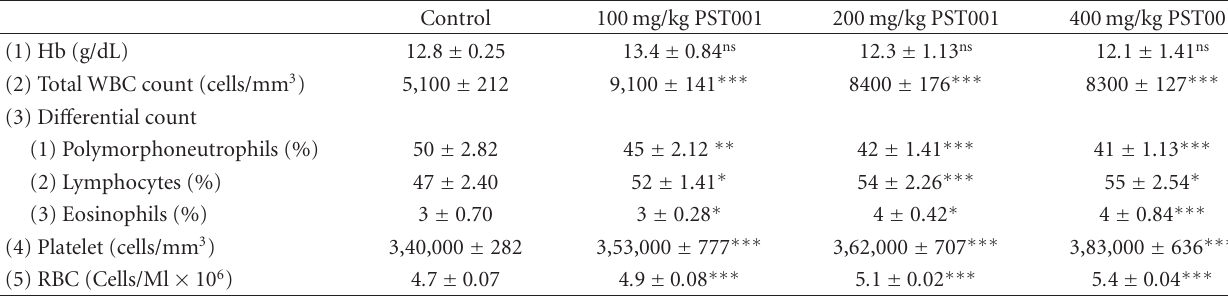
Table 6: E ff ect of PST001 on haematological parameters in mice.